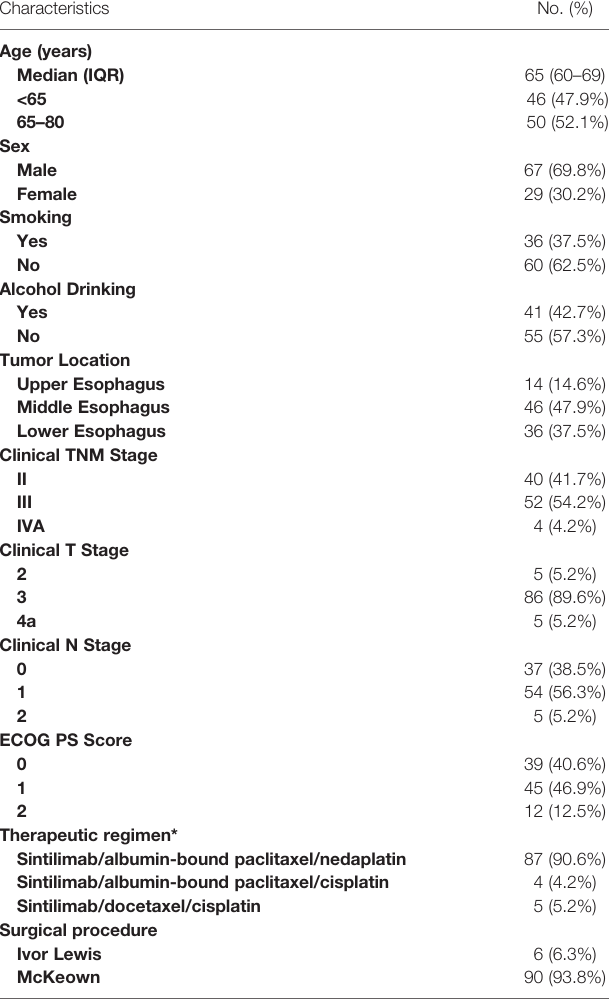
TABLE 1 | Patient baseline